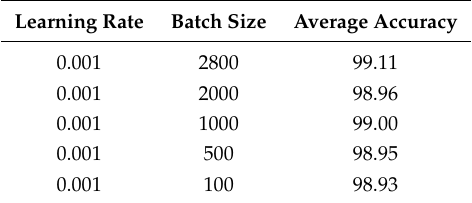
Table 2. Batch sizes and average accuracy for a learning rate of 0.001.